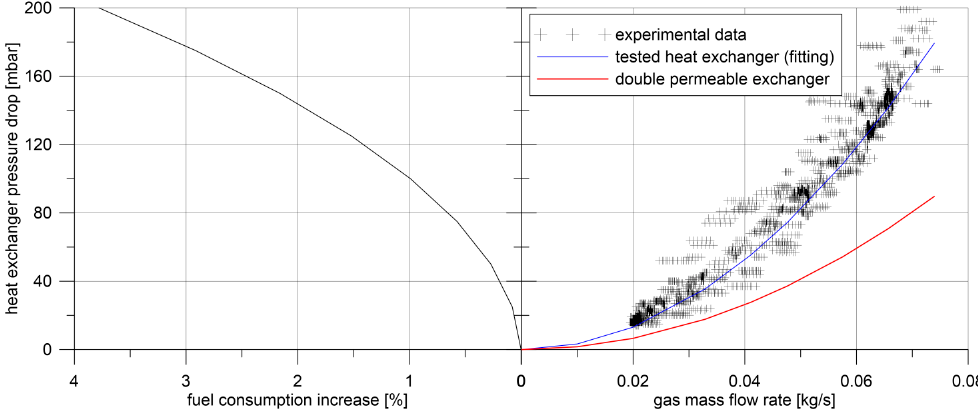
Figure 19. Fuel consumption increase related to backpressure increase and flow resistance of two heat exchangers.